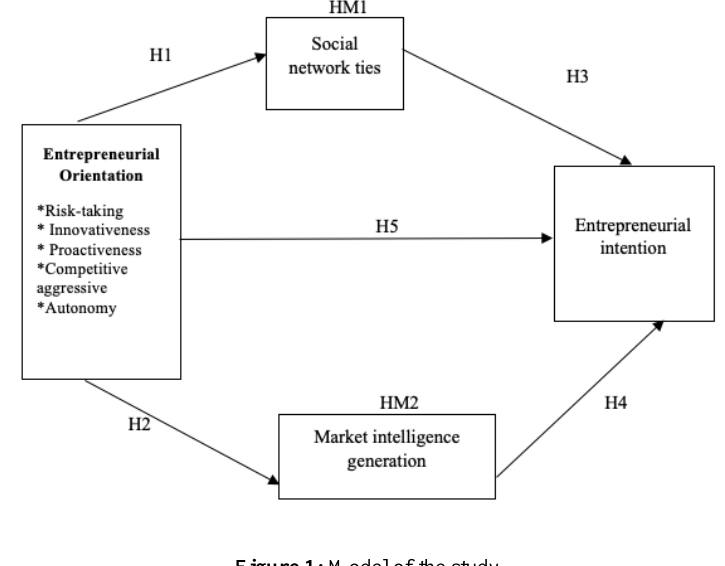
Figure 1: Model of the